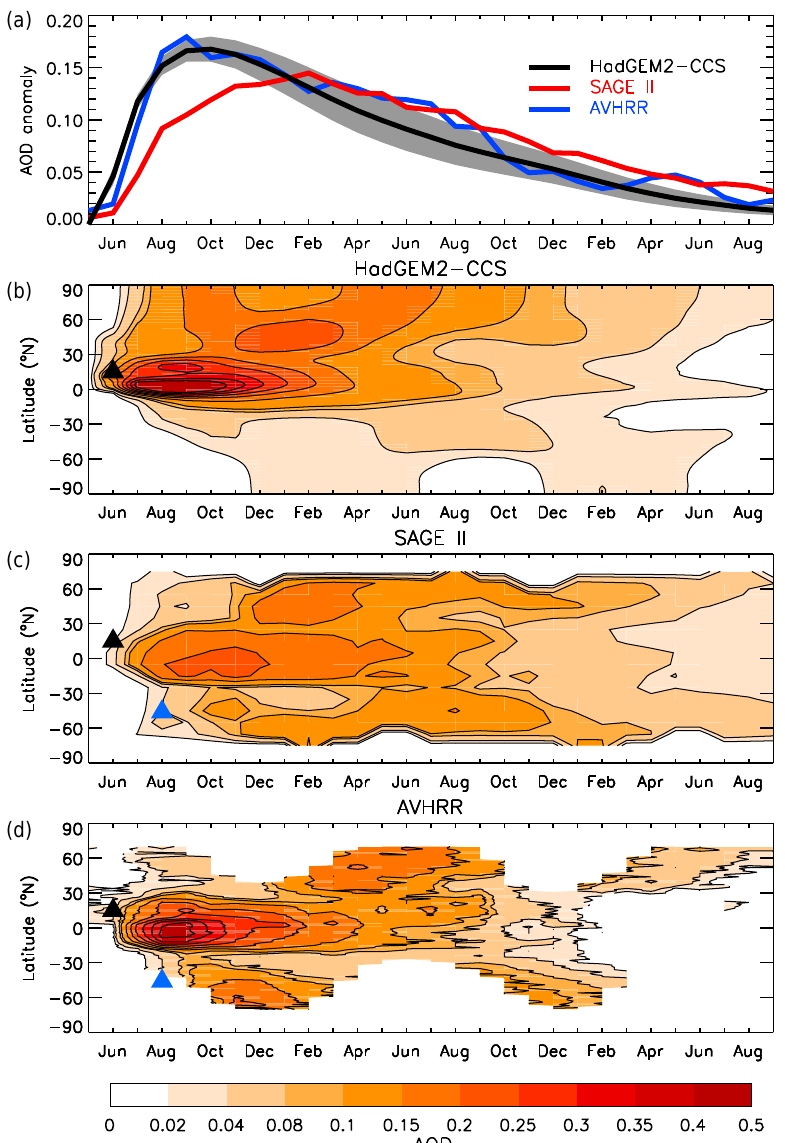
Figure 2. (a) 75 ◦ S–75 ◦ N-mean 550nm sulfate AOD anomaly for the Pinatubo simulations and observations, (b–d) time series of zonal- mean 550nm sulfate AOD